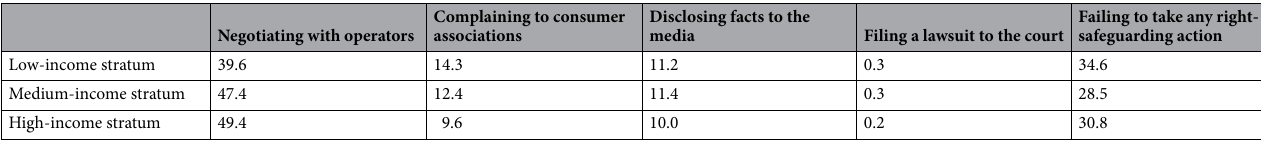
Table 5. The selection of right-safeguarding means Unit: %.